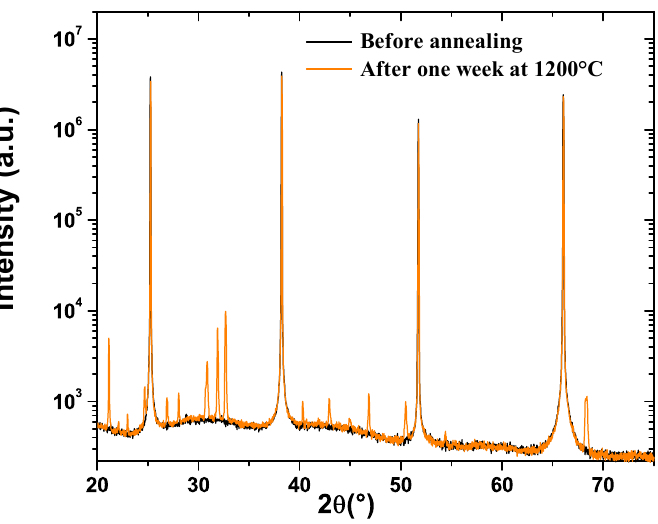
Figure 3. SEM images of the LGS surface after a one-week annealing period at 1200 °C in an air atmosphere. ( a ) Overall image of the substrate: the surface appears sprinkled with isolated defects. ( b ) A closer view of some defects. ( c ) A typical defect. Red and orange squares symbolize the EDXS measurement areas. ( d ) A close-up view of the center of the latter defect. The white arrow indicates a stick with crystalline facets.